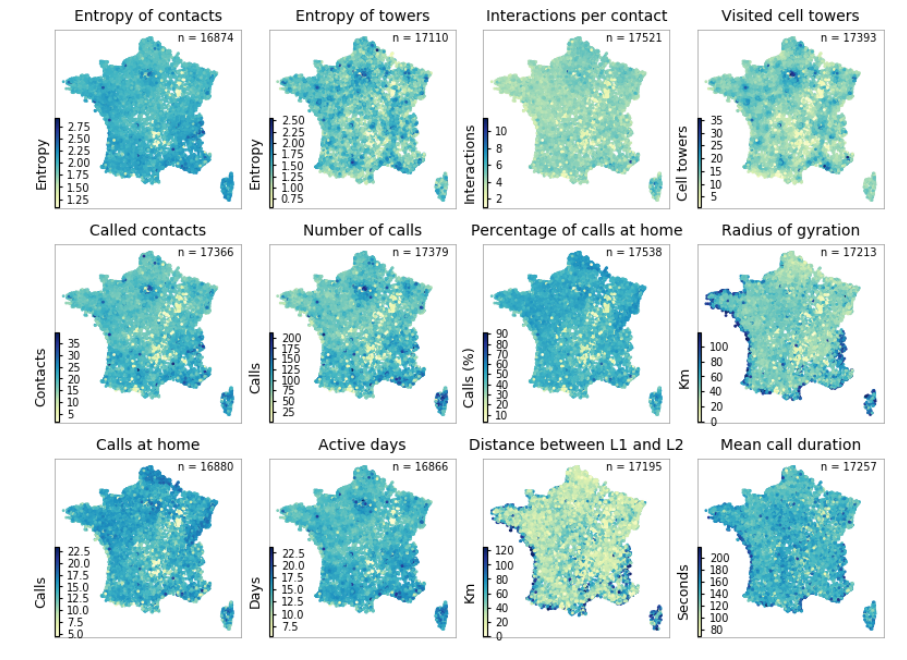
Figure 2. Maps of several mobile phone indicators at cell tower level. Indicators are computed for September 2007, for all users in the French CDR dataset. Users are aggregated at cell tower level by the the Distinct Days Algorithm. Each dot on the map is a cell tower and displays the average indicator value of all users allocated to this cell tower. Cell towers with an average value that is higher, or lower, than 3 standard deviations from the nationwide average are omitted, hence the differing number of displayed cell towers ( n ) between